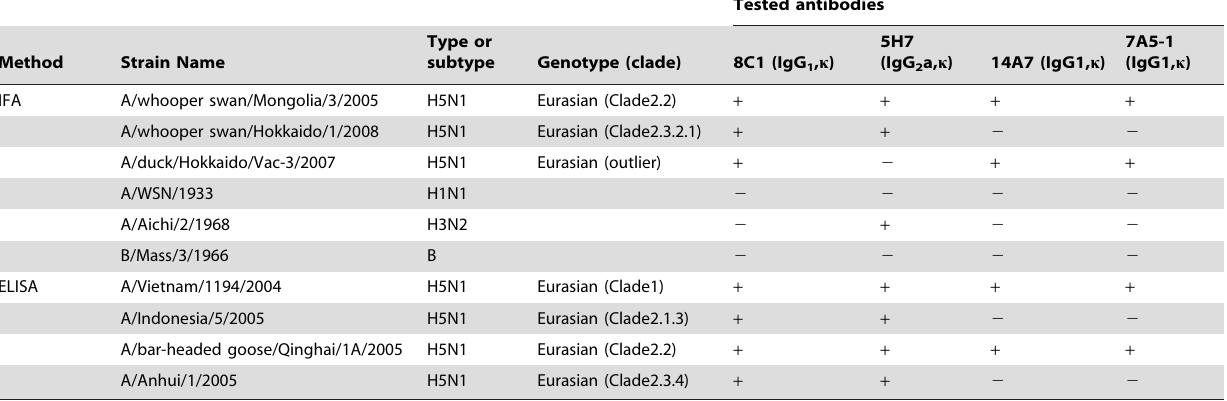
Table 1. Specificities of Antibodies against H5 protein.